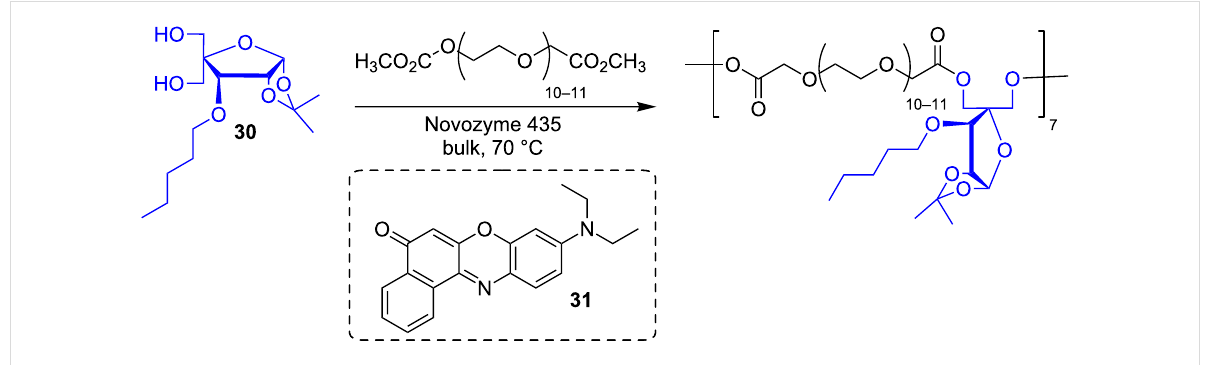
Figure 7: Polyesters containing functionalized pentofuranose derivatives.